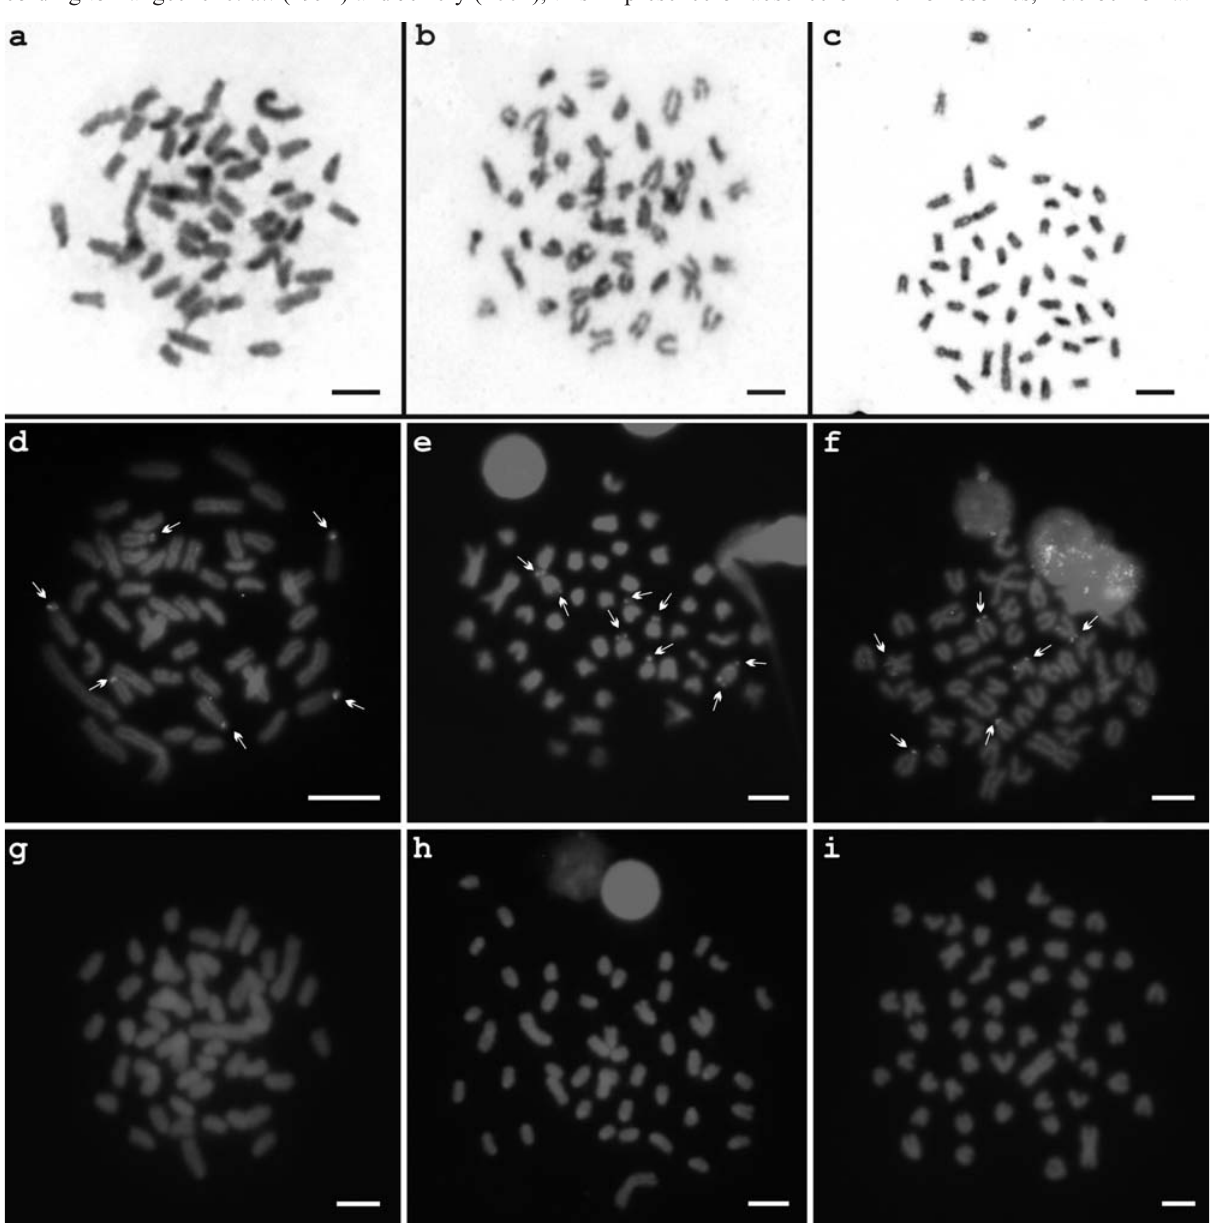
Figure 3 - Metaphases of Astyanax hastatus. Cytotypes A, B and C after C-banding (a-c), and FISH with rDNA 18S (d-f) and satellite DNA As-51 (g-i) probes. The arrows indicate rDNA sites. Bars = 5 (cid:2)